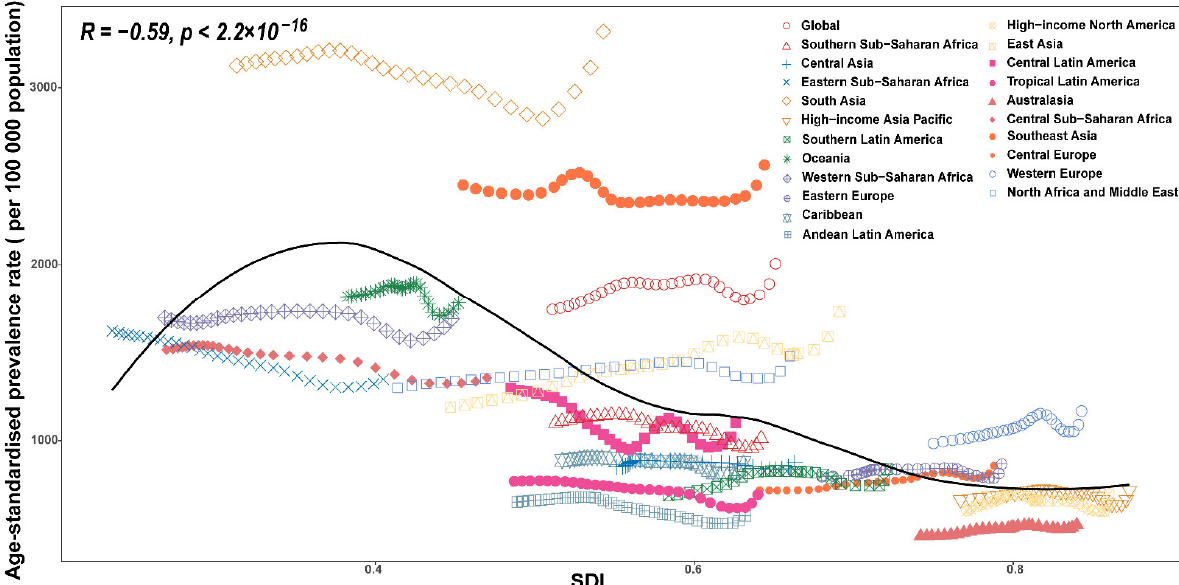
Figure 4. Age-standardized prevalence rates for protein–energy malnutrition for 21 GBD regions by socio-demographic index (SDI), 1990–2019. There was clearly an ASPR downtrend of the prediction curve when the SDI went up. Expected values based on the socio-demographic index and disease rates in all locations are shown as the black line.